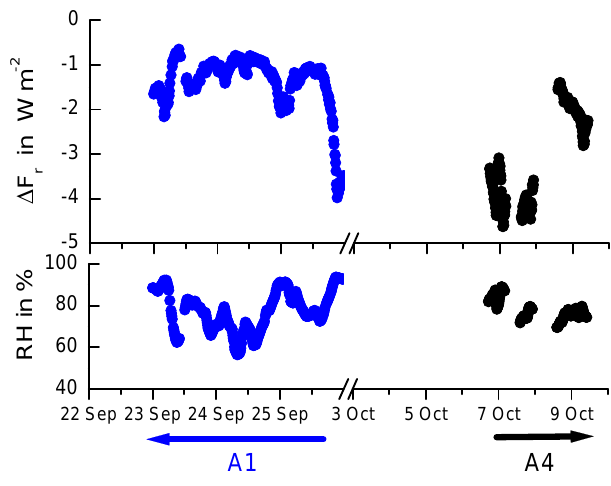
Fig. 15. Time series of the calculated aerosol direct radiative forc- ing ( 1F r ) at ambient conditions as well as the ambient RH for both marine (A1) and continentally polluted (A4)